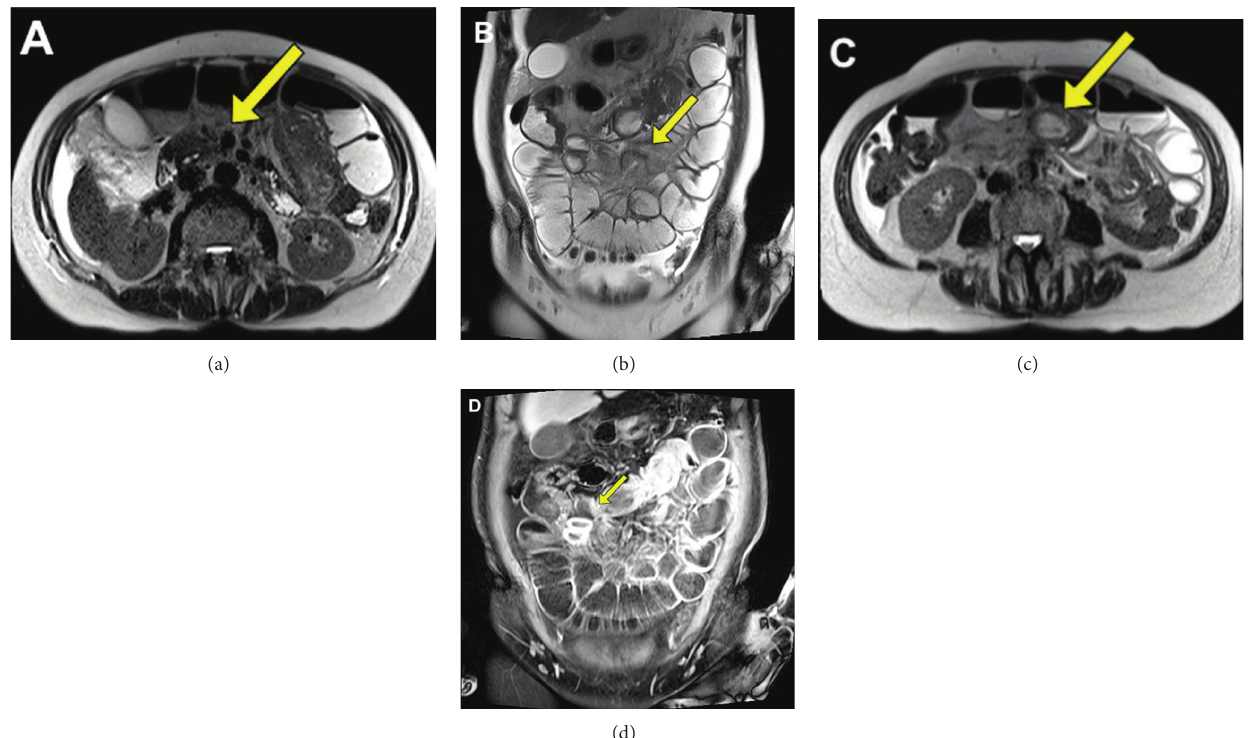
Figure 8: Axial (a) and coronal (b) partial-Fourier images through the pelvis show longitudinal bowel-in-bowel appearance with mesenteric fat and vessels being drawn into the intussusception. Sections through the lead point, edematous polyp, shown on axial images (c). Coronal section clearly delineates a T2 hyperintense, hypovascular, lead point